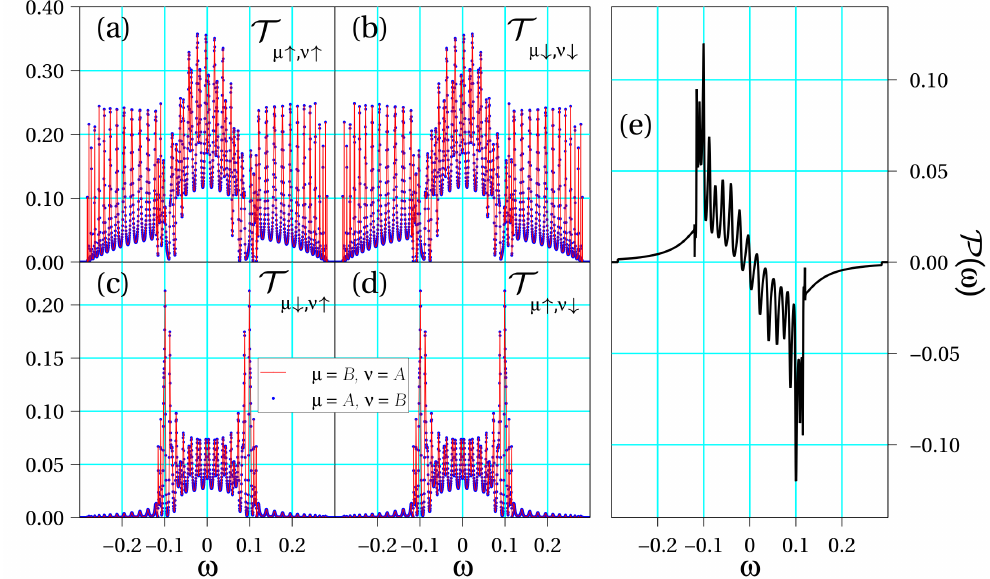
Figure 2. Transport coefficients obtained for a symmetric molecule: ε A = ε B = 0.0, t A = t B = 0.1, λ A = λ B = 0.01, α c = − 0.08, θ = 0.66, N st = 10, N tr = 3 and Γ 0 = 1.0. Transmission coefficients ( a ) T µ ↑ , ν ↑ ( ω ) ; ( b ) T µ ↓ , ν ↓ ( ω ) ; ( c ) T µ ↓ , ν ↑ ( ω ) ; ( d ) T µ ↑ , ν ↓ ( ω ) ; and ( e ) spin polarization P ( ω ) as a function of